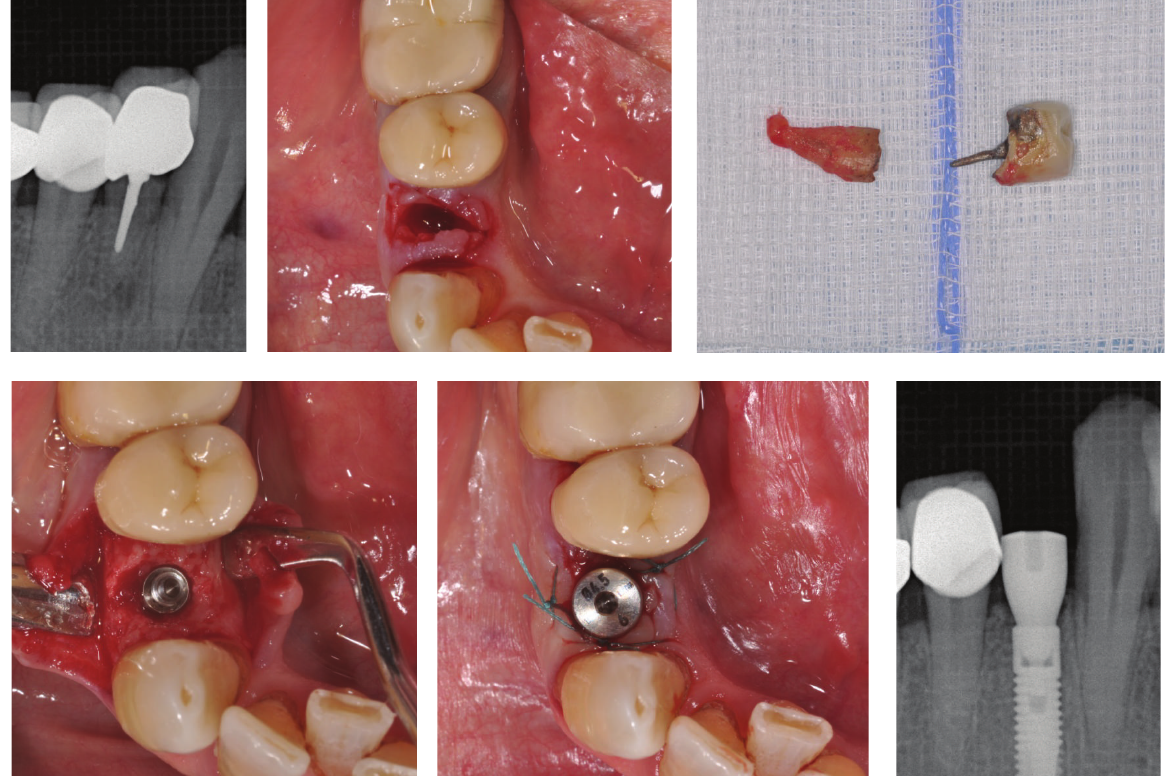
Figure 6: Type 1 implant positioning with transmucosal healing, surgical and radiographic